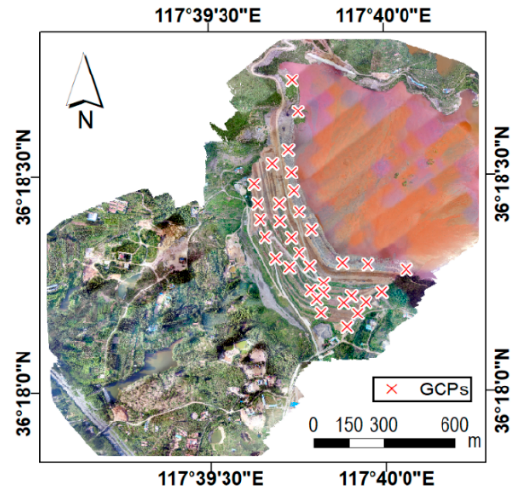
Figure 5. SfM orthophoto and ground control points (GCPs) positions of the research area during the August 2018 survey.